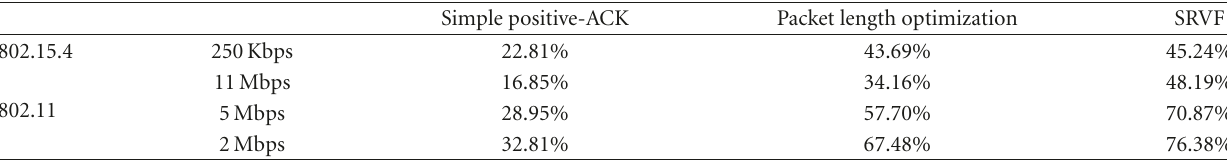
Table 1: Theoretical energy e ffi ciency.